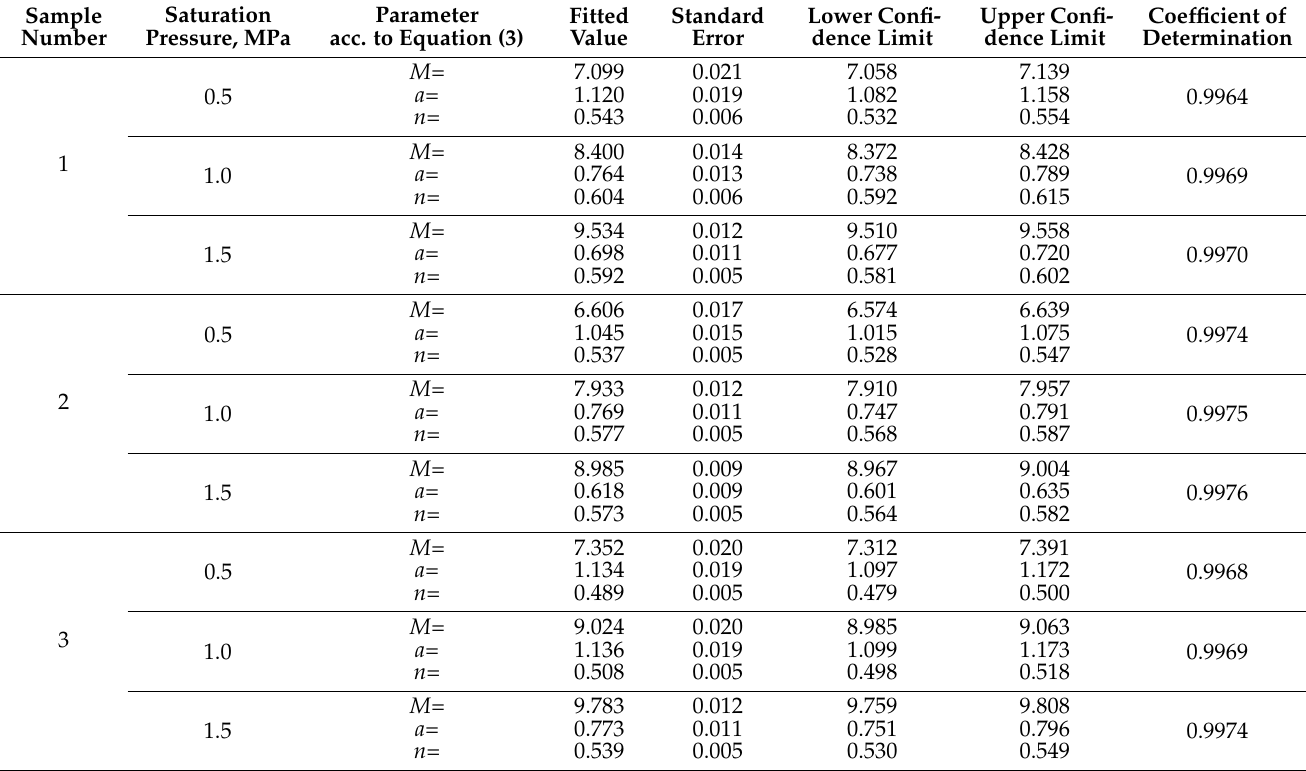
Table 2. Results of fitting Equation (3) to desorption runs for three exemplary coal samples saturated by methane at three different